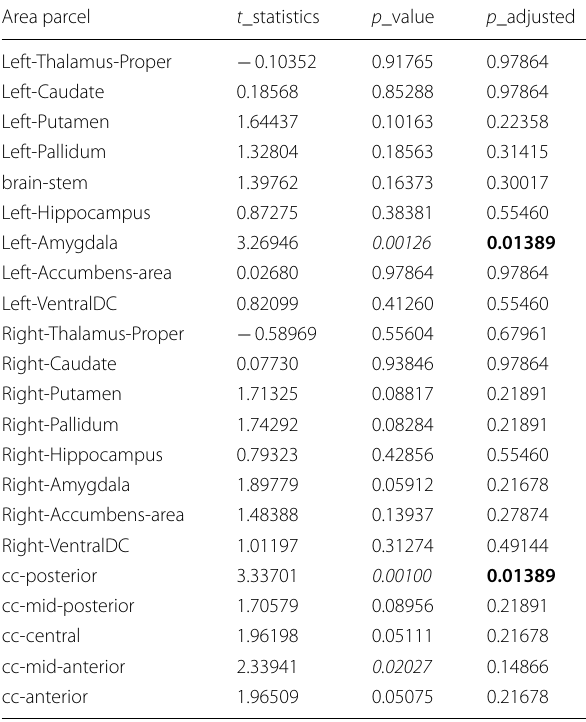
Table 4 Relations between subcortical volumes and structural MRI quality (as measured by the CAT12